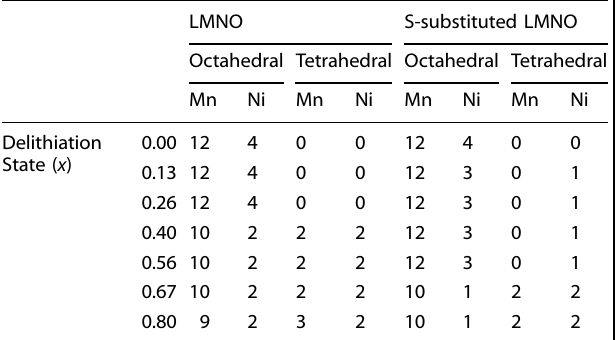
Fig. 6 Optimized con fi gurations and formation energy of O vacancy. a Side views of optimized structures for the pristine and S-substituted LNMO (003) surfaces. The black dashed circle presents the position of O vacancy. b The formation energy of O vacancy as a function of delithiated states from the pristine and S-substituted surface. Table 3. Numbers of MnO 6 and NiO 6 octahedra and MnO 4 and NiO 4 tetrahedra con fi gurations for the pristine and S-substituted LNMO (003) surfaces at different delithiation